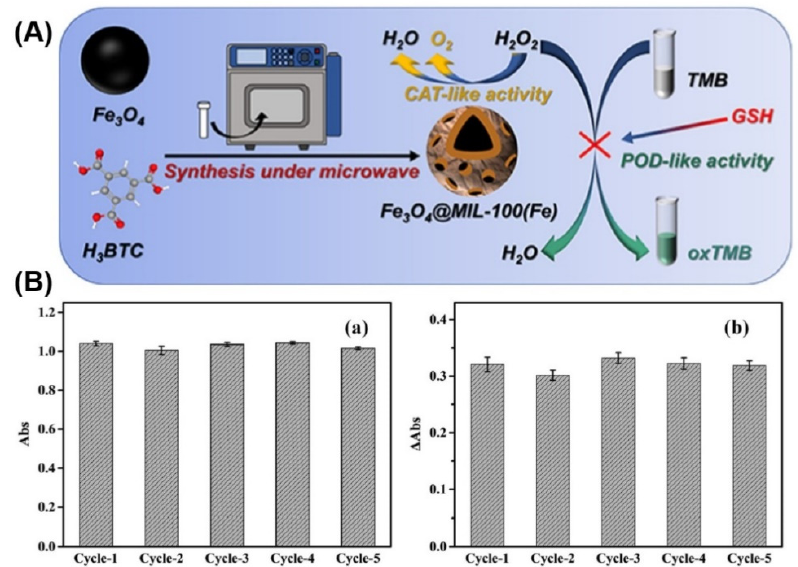
Figure 15. ( A ) Schematic illustration of colorimetric glutathione sensing by Fe 3 O 4 @MIL-100(Fe), which exhibited enhanced dual enzyme mimetic activities in the process. ( B ) Reusability of Fe 3 O 4 @MIL-100(Fe) after five cycles for H 2 O 2 ( a ) and GSH ( b ) detection [152]—Copyright 2021 Elsevier.